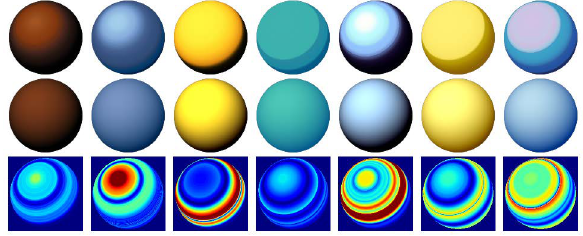
Fig. 9 Comparison of reflectance models. Top: color map materials selected from our dataset. Middle: Lambertian material fitted to the corresponding color map. Bottom: color difference between the color map materials and Lambertian materials. The materials are listed according to the color